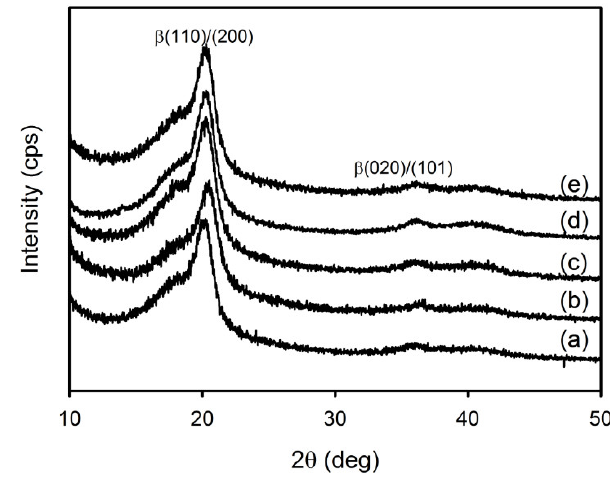
Figure 5. XRD patterns of (a) PVDF, (b) PE02, (c) PE04, (d) PE06, and (e) PO06 composite nanofibers.